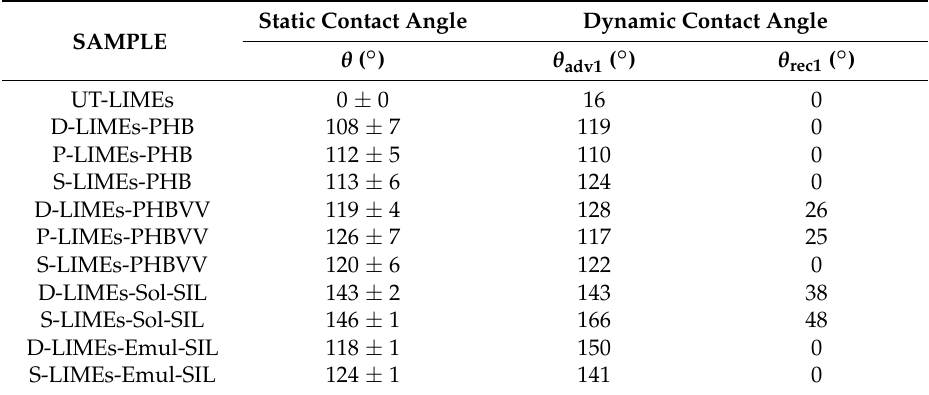
Table 6. Static contact angle ( θ ) and dynamic contact angles referred to the first immersion cycle ( θ adv1 , θ rec1 ) for untreated and treated limestone.